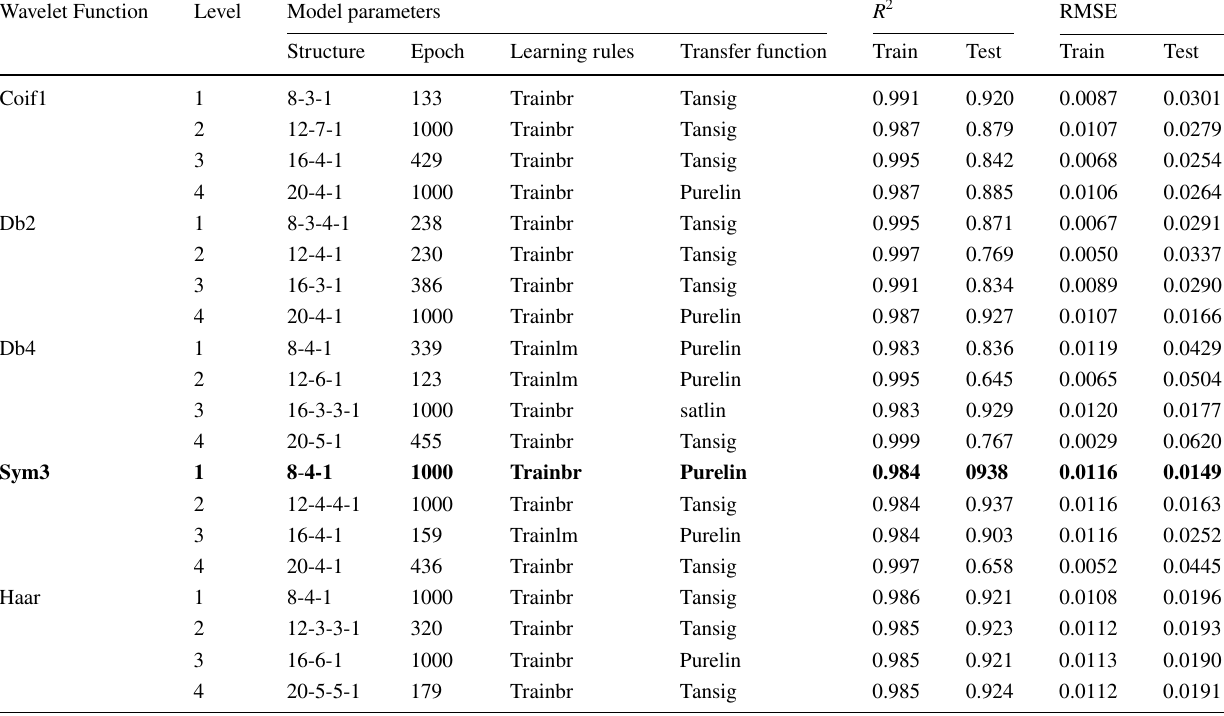
Bold values represent the